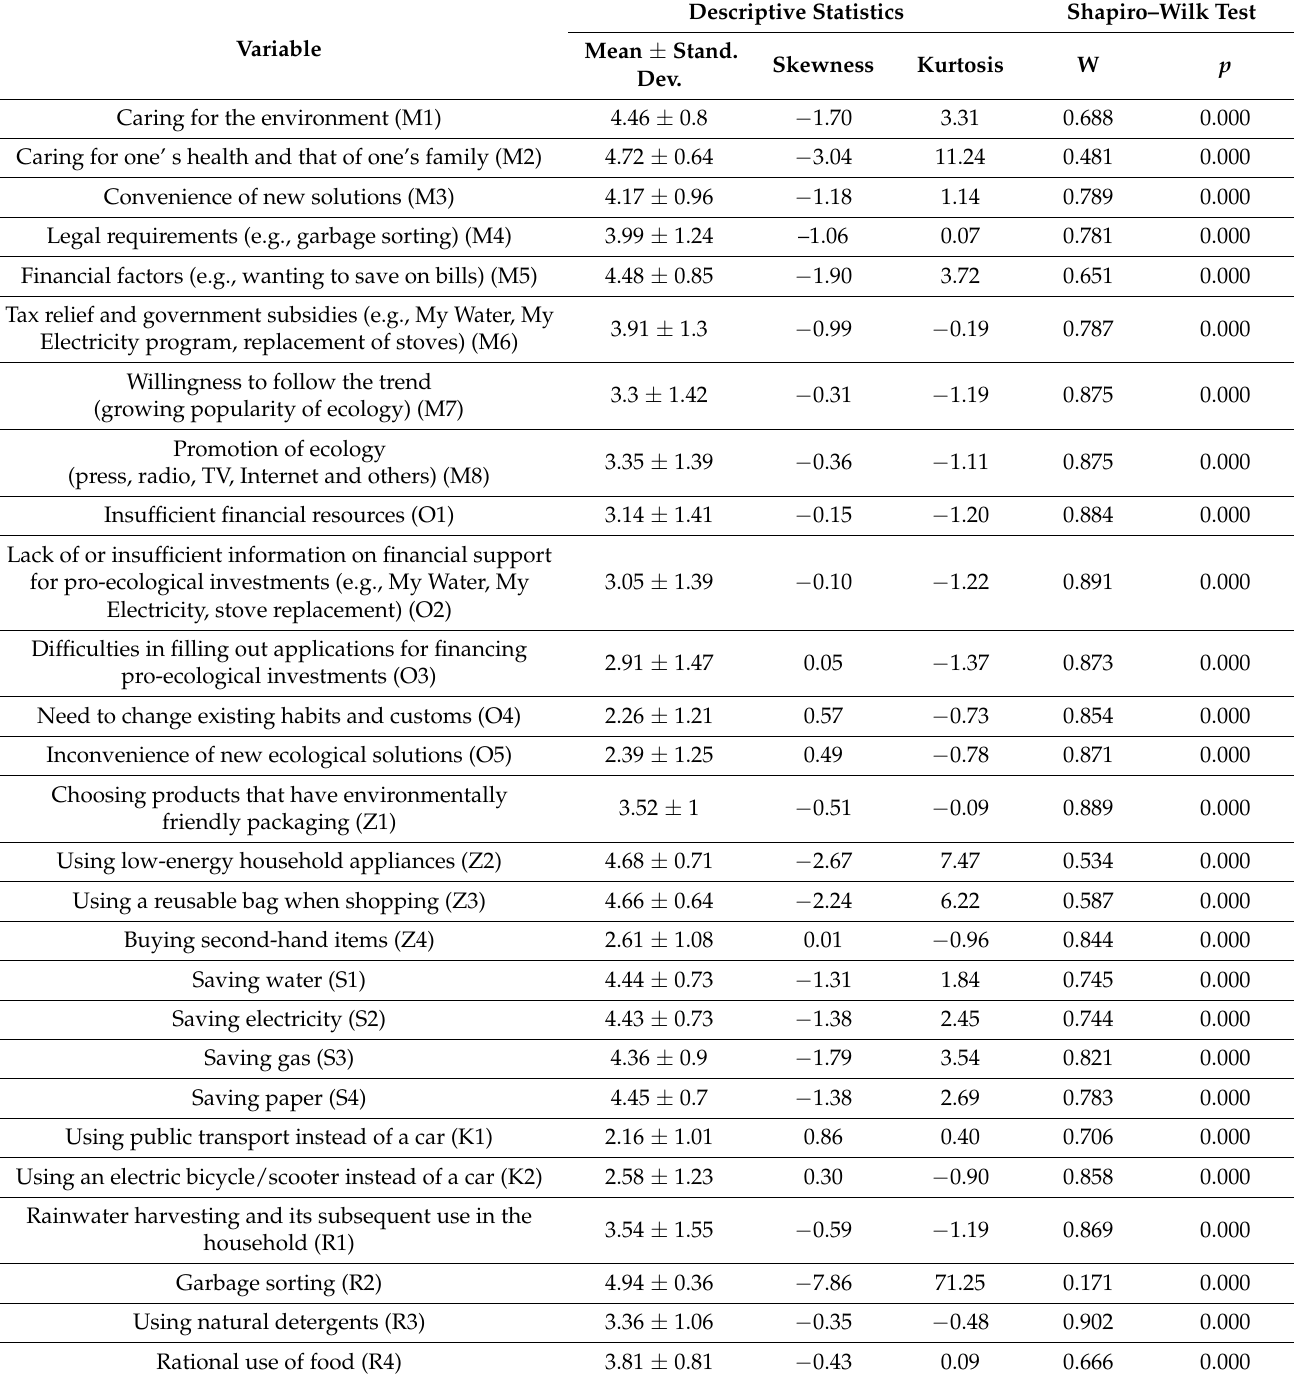
Table 2. Descriptive statistics of the distributions of the variables used and normality